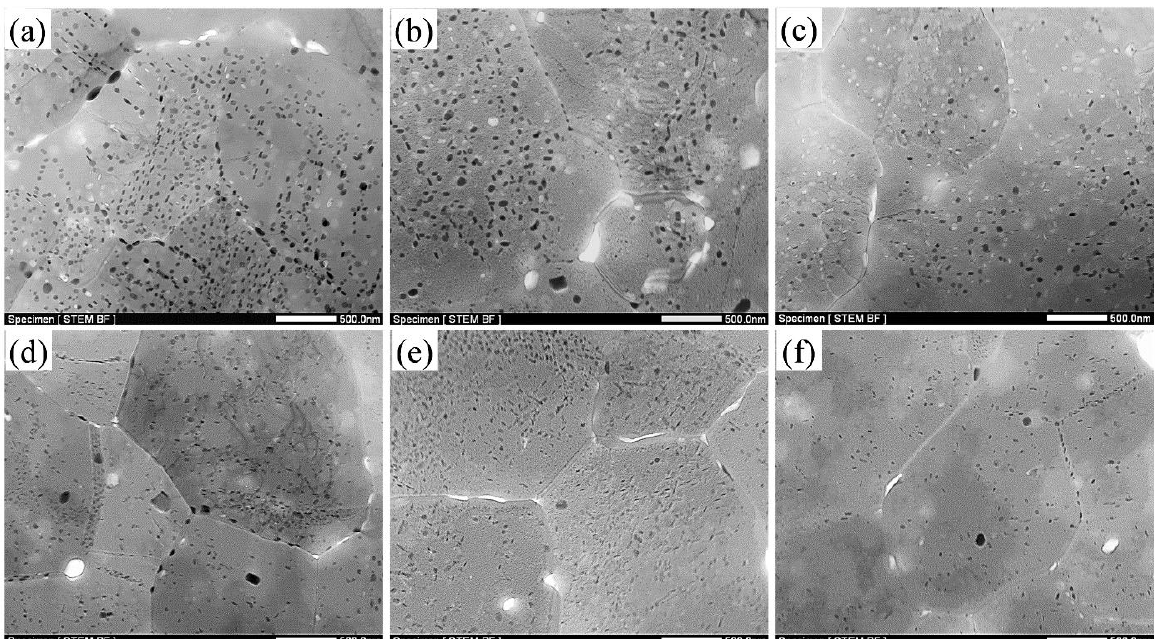
Figure 4. STEM images in LHZ and HHZ of the builds in the different aging states: ( a ) LHZ in the NA-7 d state; ( b ) LHZ in the 120 °C × 24 h state; ( c ) LHZ in the 100 °C × 48 h state; ( d ) HHZ in the NA-7 d state; ( e ) HHZ in the 120 °C × 24 h state; ( f ) HHZ in the 100 °C × 48 h state.